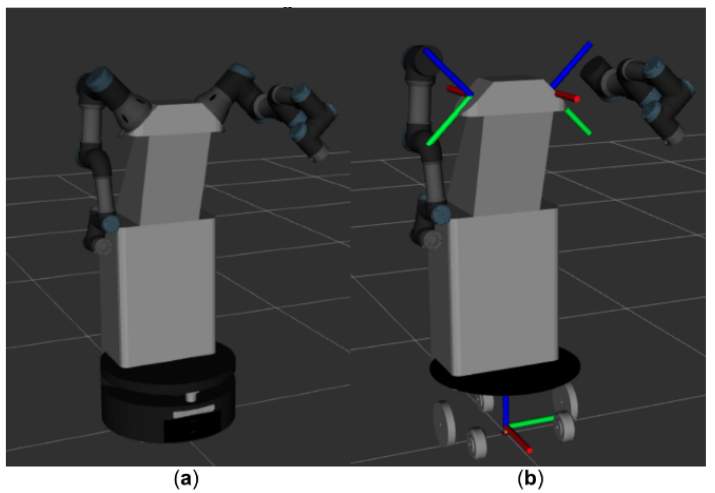
Figure 8. Robot visualized in Rviz: ( a ) complete robot model; ( b ) reference axes of the robot base and of its two arms.